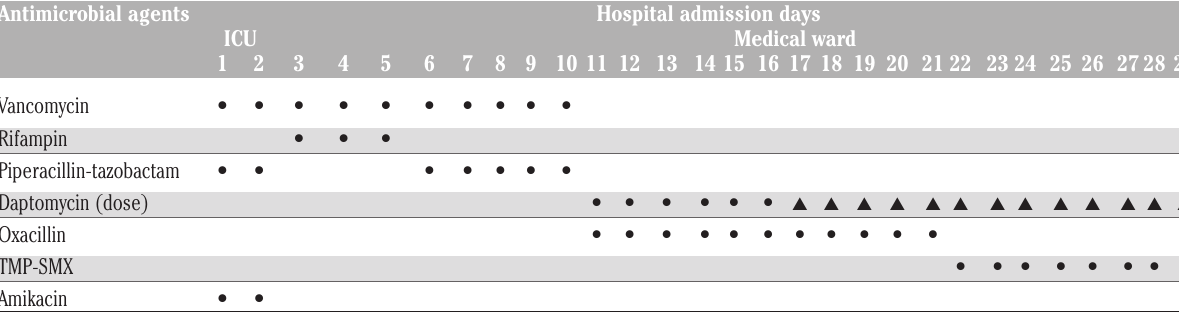
Table 2. Antimicrobial agents administered during hospital stay along with MRSA bacteremia status. Antimicrobial agents